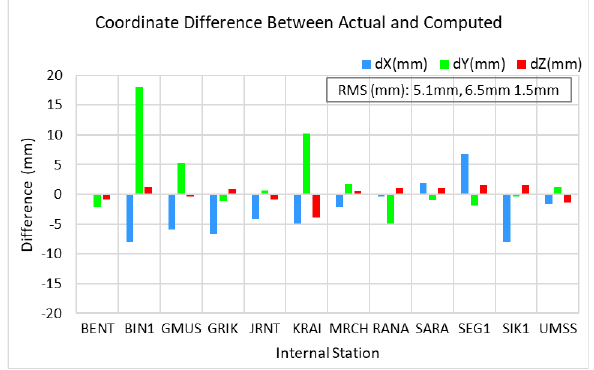
Figure 6 . Coordinate difference at Independent Station (internal) after applying the 7p Bursa-Wolf